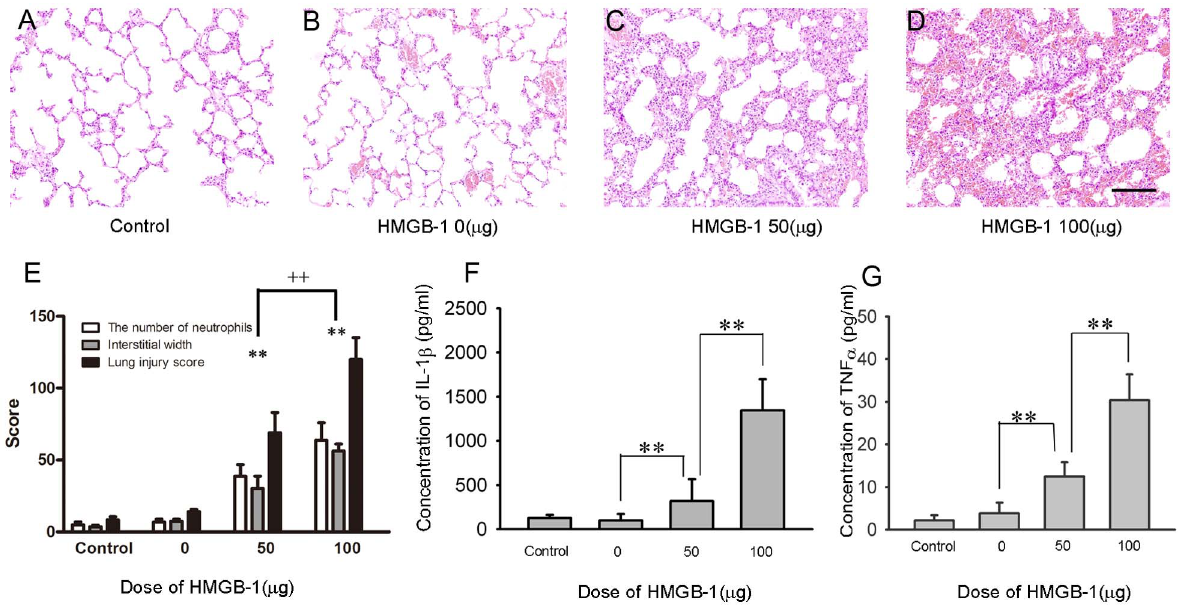
Figure 1. Lung inflammatory response after HMGB-1 treatment. Normal lung architecture was observed in the control group and 0 m g HMGB-1 group (A, B). Intense interstitial accumulation of neutrophils and edema was observed in 50 m g and 100 m g HMGB-1 groups (C, D). Rats exposed to 0 m g HMGB1 showed low lung histological scores. Intratracheal exposure of 50 m g and 100 m g of HMGB1 increased lung histological scores significantly (E). IL-1 b and TNF- a levels in lungs were evaluated by ELISA. Compared with the control group, inflammatory mediators in the 0 m g HMGB-1 group were not significantly different, and marked increases were observed in 50 m g and 100 m g HMGB-1 groups (F, G). The increases in the 100 m g HMGB-1 group were higher than those in the 50 m g HMGB-1 group (F, G). Data are shown as the mean 6 SD, n=6, * P , 0.05,